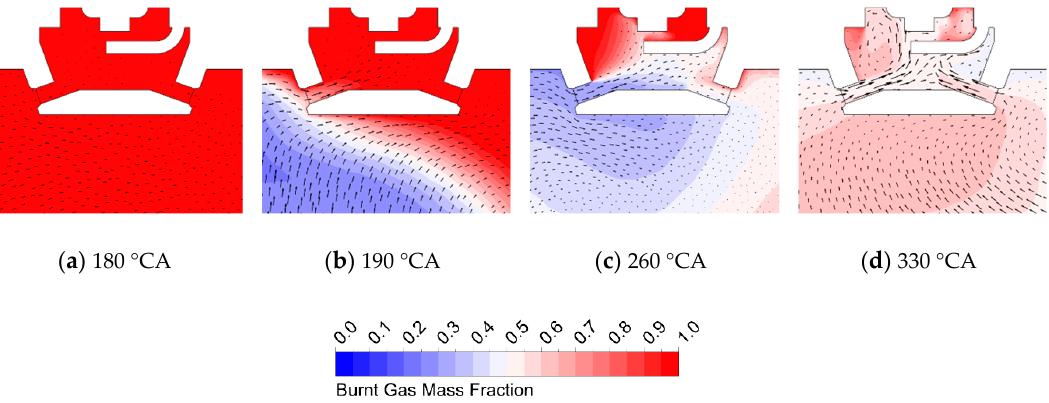
Figure 10. Scavenging behavior at 7500 rpm and 30% of load inside the PN8 prechamber.